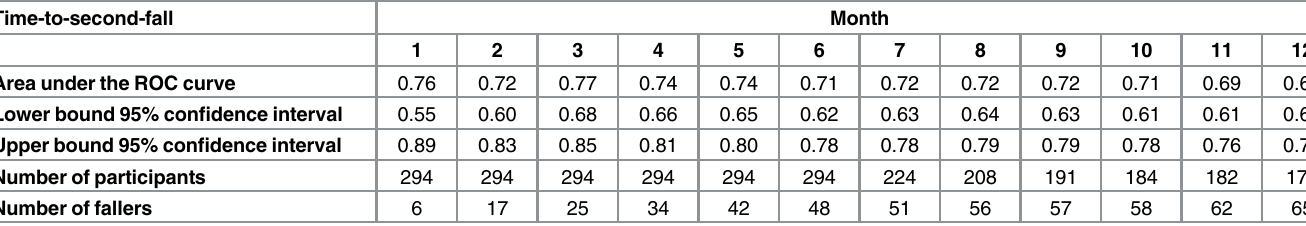
Table 4. Predictive ability of multivariate prediction model for